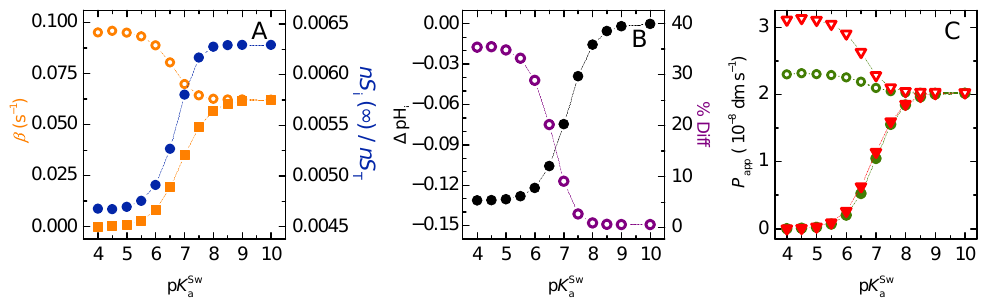
Figure 9. Effect of the solute’s acidity constant: ( A ) Variation of the characteristic constant ( (cid:4) ) and the ratio between β and the fraction of neutral solute in the outer compartments ( ). Fraction of the (cid:35) concentration of solute in the inner compartments at equilibrium ( • ). ( B ) Maximum pH variation in the inner aqueous phase ( • ), and percentual error between the apparent permeability coefficients obtained from the general and the simplified equations ( ). ( C ) Apparent permeability coefficient (cid:35) calculated from the general equation ( P app • ), and from the simplified equation ( P r app (cid:72) ). The hollow symbols represent the ratio between the apparent permeability coefficient and the fraction of the protonated solute in the membrane. The dotted lines are guides for the